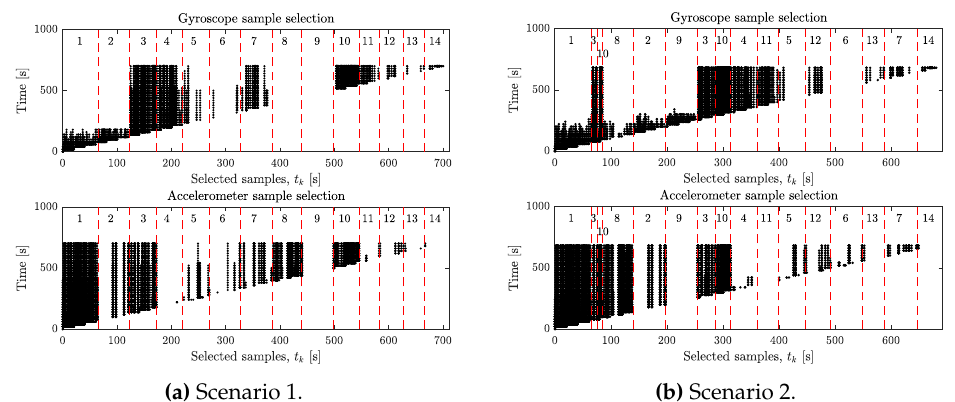
Figure 7. The figure shows which samples from Scenario 1 ( a ) and Scenario 2 ( b ) that were selected by Algorithms 2–3 with N max = 1000, at the times given by the vertical axes. Black/white indicates that a sample were selected/not selected respectively. As time increases and more samples become available, we see some previously selected samples being deselected in favor of new samples that are deemed superior by the algorithms. Vertical dashed lines and the numbers 1–14 indicate from which motions (see Section 7.1) the data comes